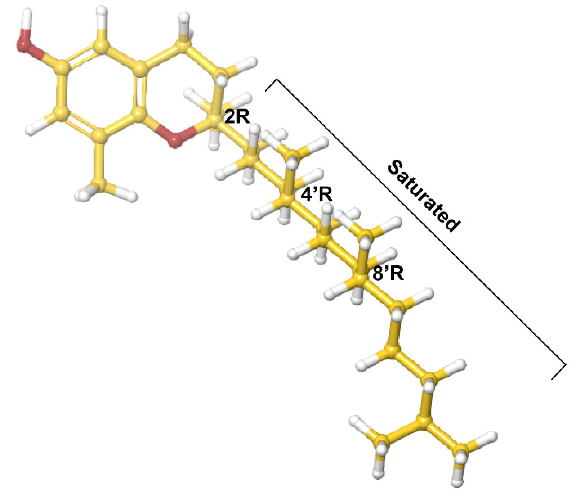
Figure 1. δ -Tocopherol.